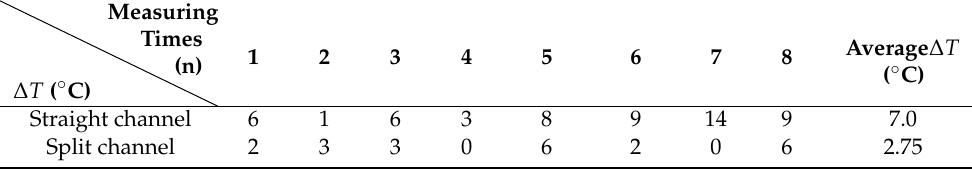
Table 5. Comparison of temperature difference between 1st and 3rd strands in two channels. Measuring